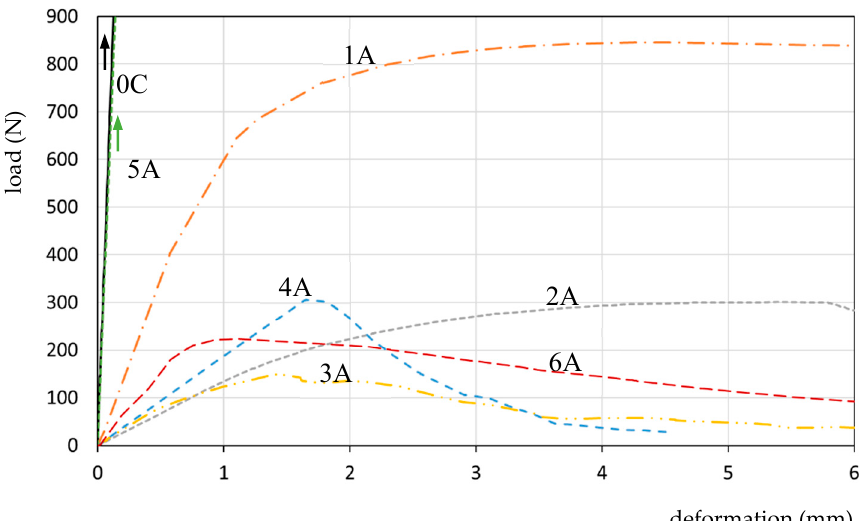
Figure 10. The load–deformation curves for specimens 1A, 2A, 3A 4A 5A, 6A and the reference specimen 0C.